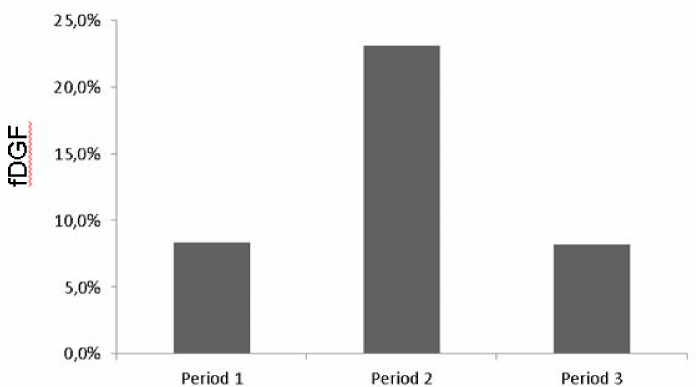
Figure 2. Incidence of fDGF in recipients during the di ff erent time periods. Period 1: